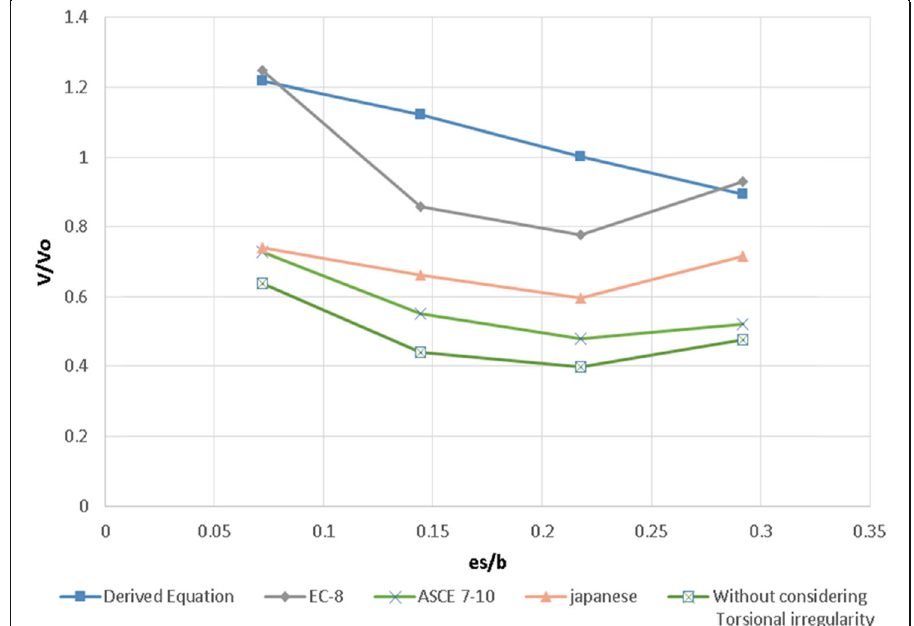
Fig. 46 Comparison of eccentricity ratio — design force ratio (design force in un-symmetric model V o , normalized by design force in symmetric plan V) for stiff side elements for ASCE 7-10, EC-8, Japanese, derived equation, and without considering Torsional irregularity